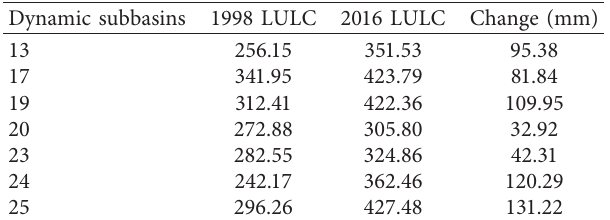
Table 11: Simulated surface runoff (mm) for selected dynamic subbasins. Dynamic subbasins 1998 LULC 2016 LULC Change